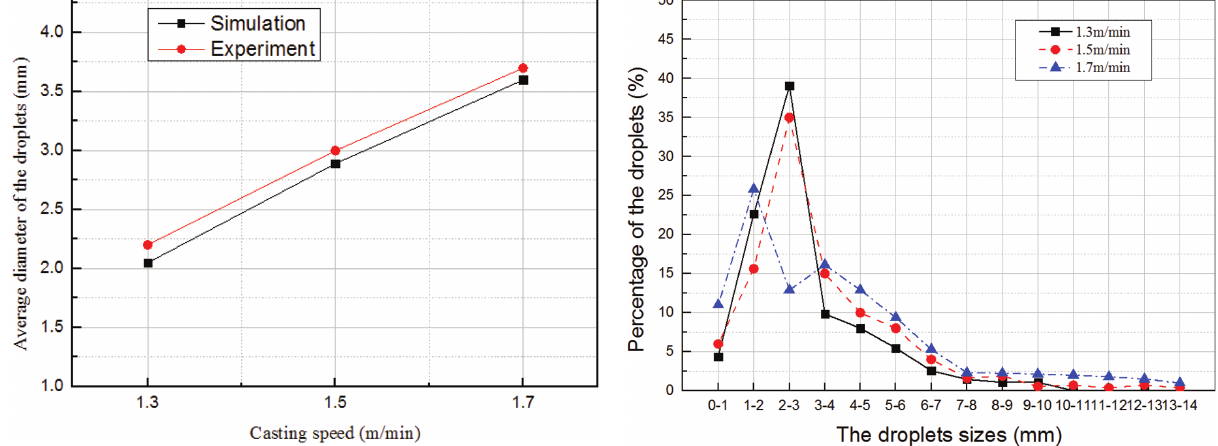
Figure 15: The comparison results for the average diameters of the entrained droplets between calculation and experiment at different casting speeds.